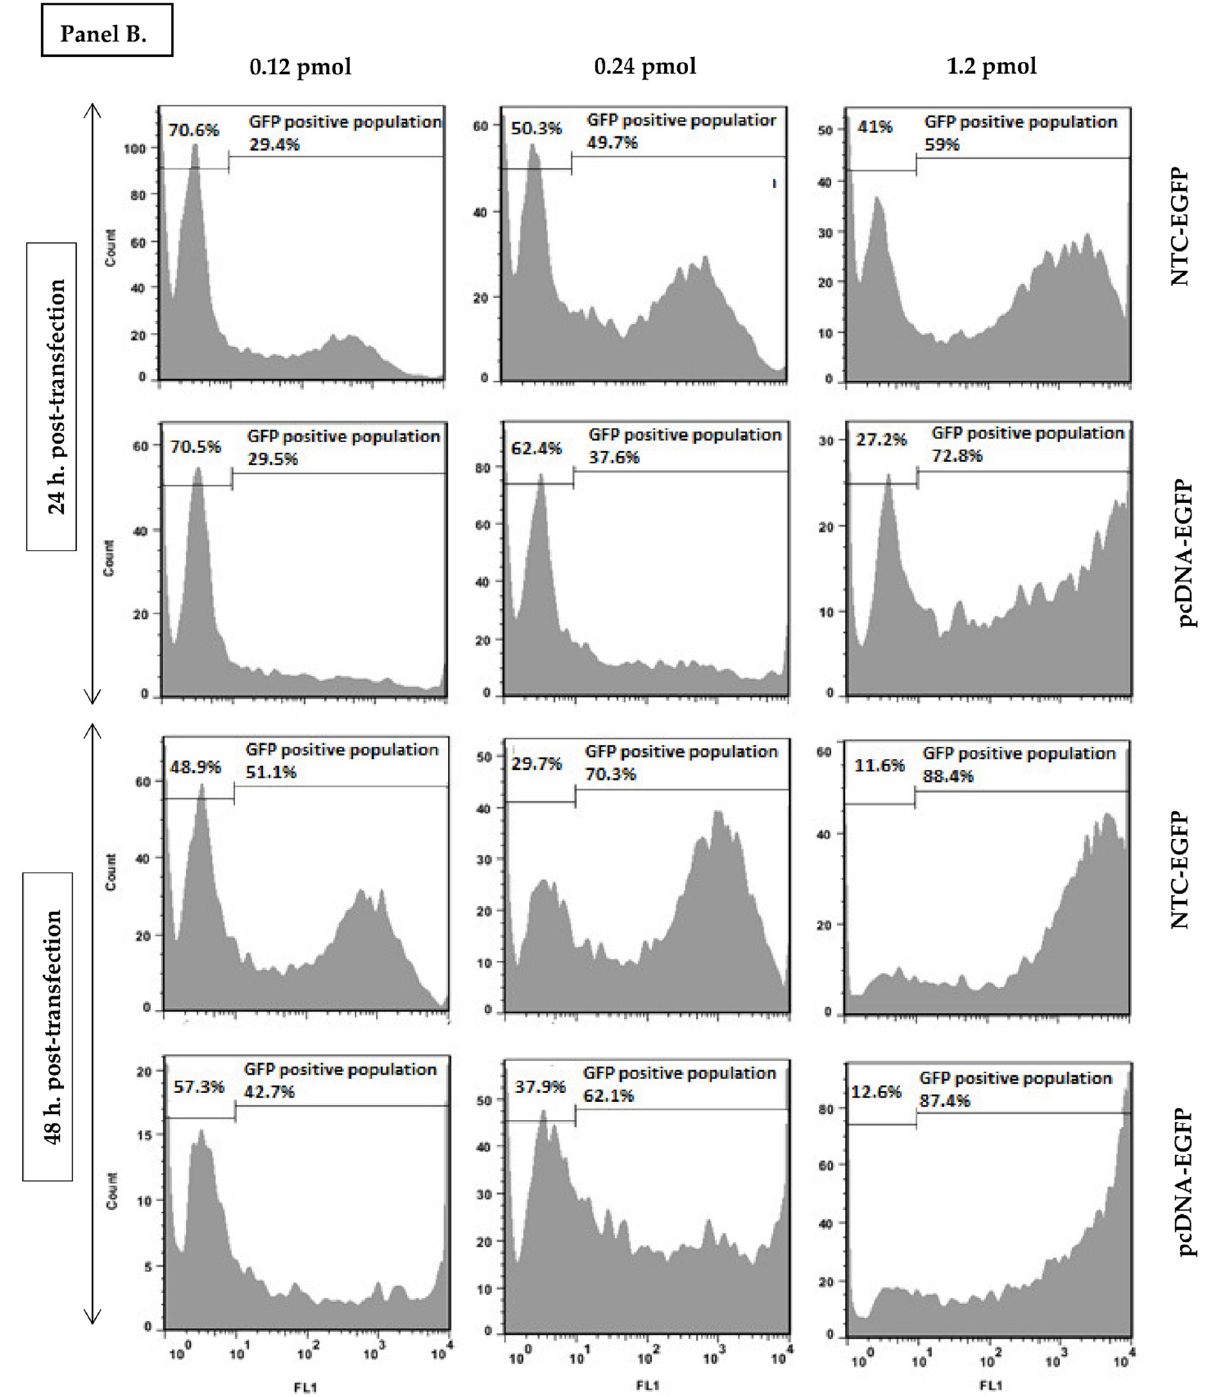
Figure 3. Representative plots of NTC-EGFP and pcDNA-EGFP transfection. EGFP positive pop- ulation of COS-7 cells transfected with equal concentrations (Panel ( A )) and equimolar concentra- tion (Panel ( B )) of NTC-EGFP and pcDNA-EGFP was evaluated by flow cytometry 24 h and 48 h post